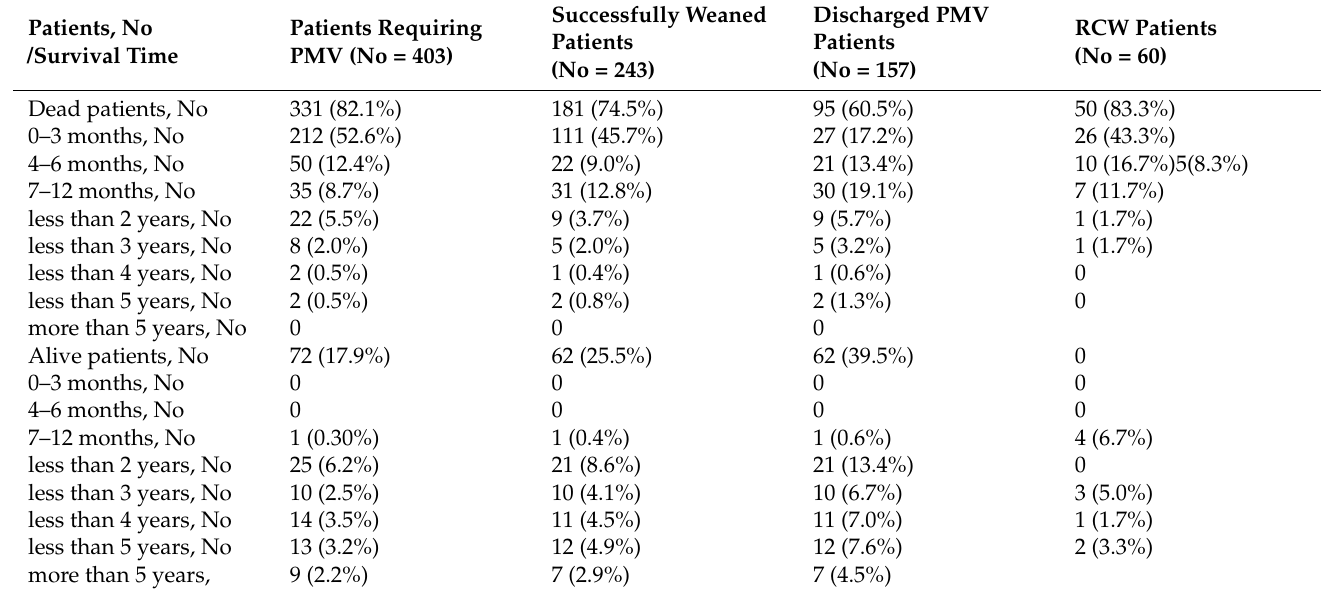
Table 2. The survival time of 403 prolonged mechanical ventilation patients.